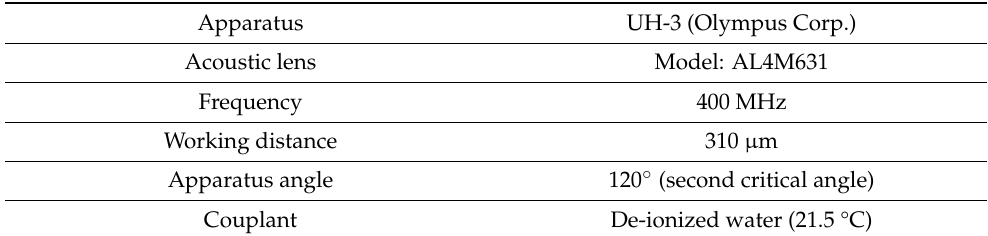
Table 3. Experimental conditions for the leaky surface acoustic